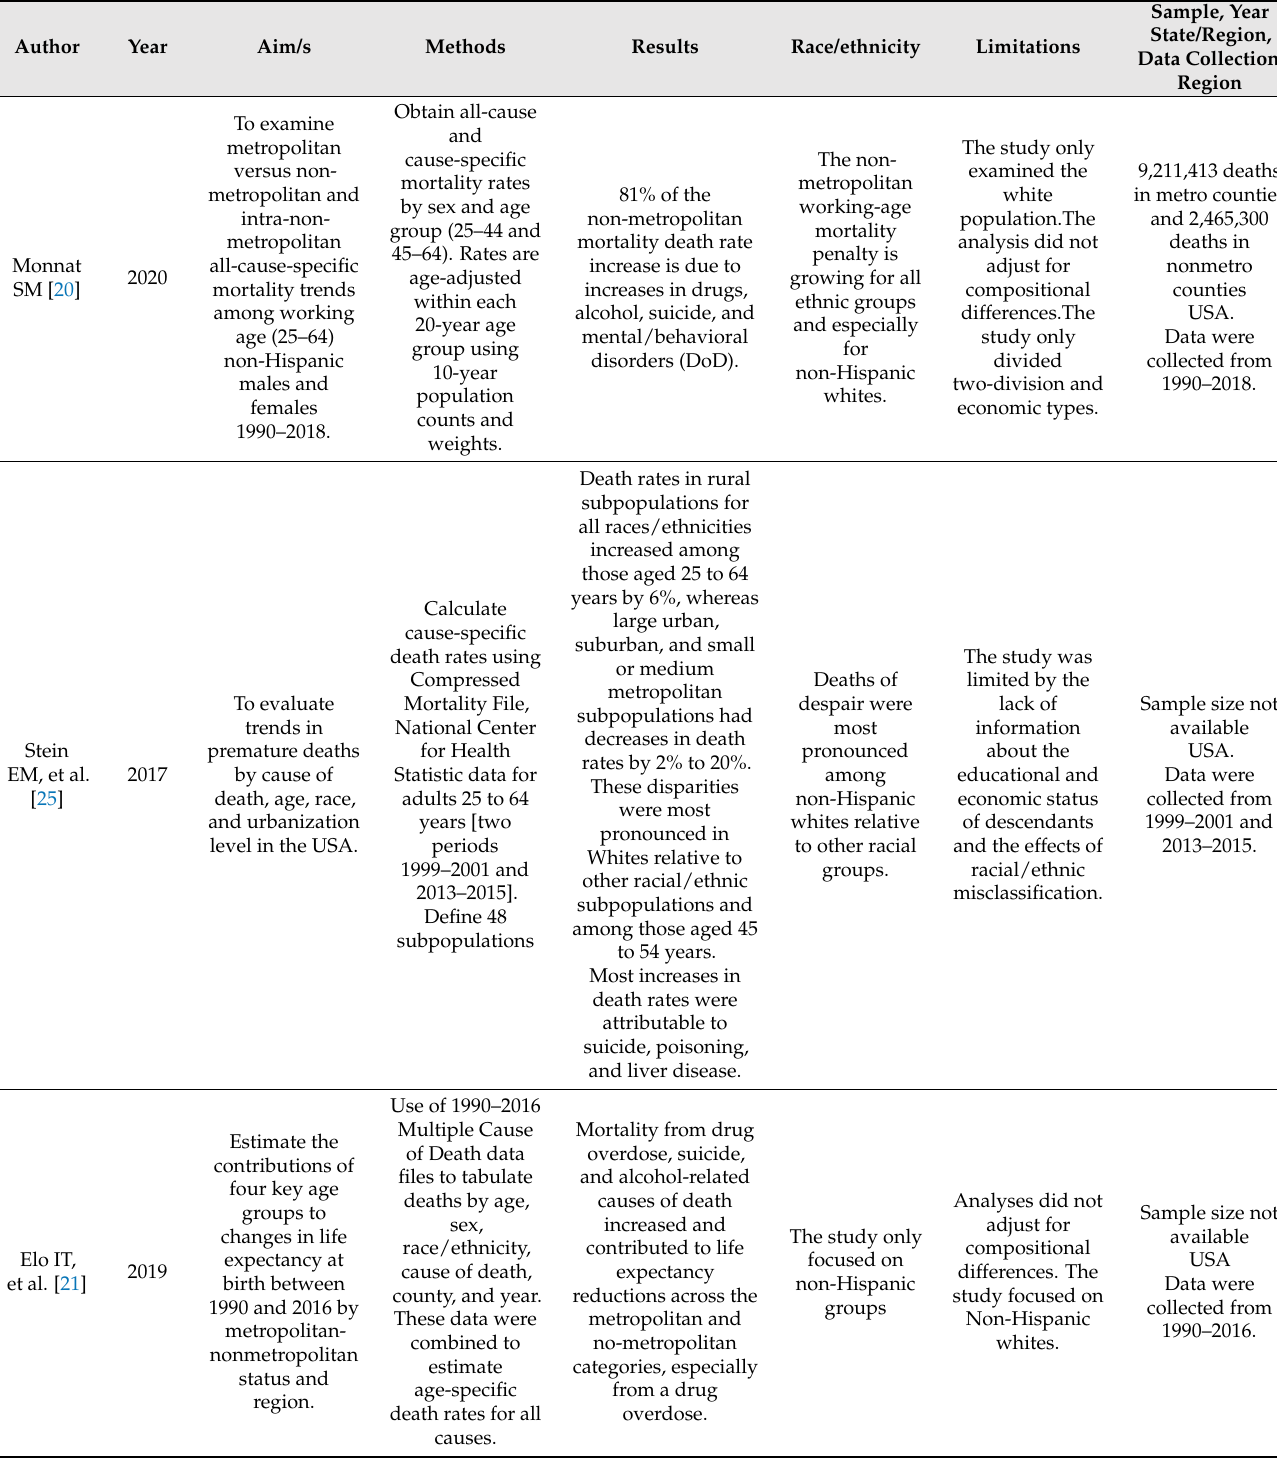
Table 4. Studies addressing Deaths of Despair according to geographical